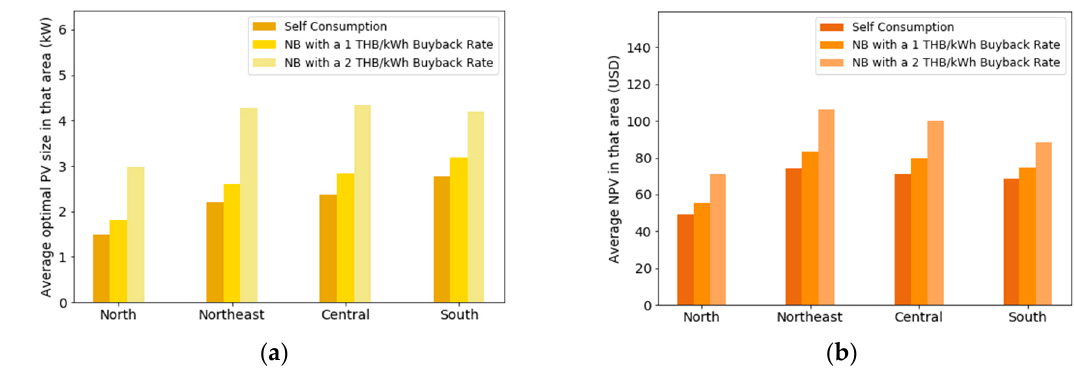
Figure 6. Comparison of ( a ) average optimal PV size and ( b ) average NPV by region for residential customers under a block rate. (Note: The average optimal PV size and the average NPV are the average values among all provinces within a region).